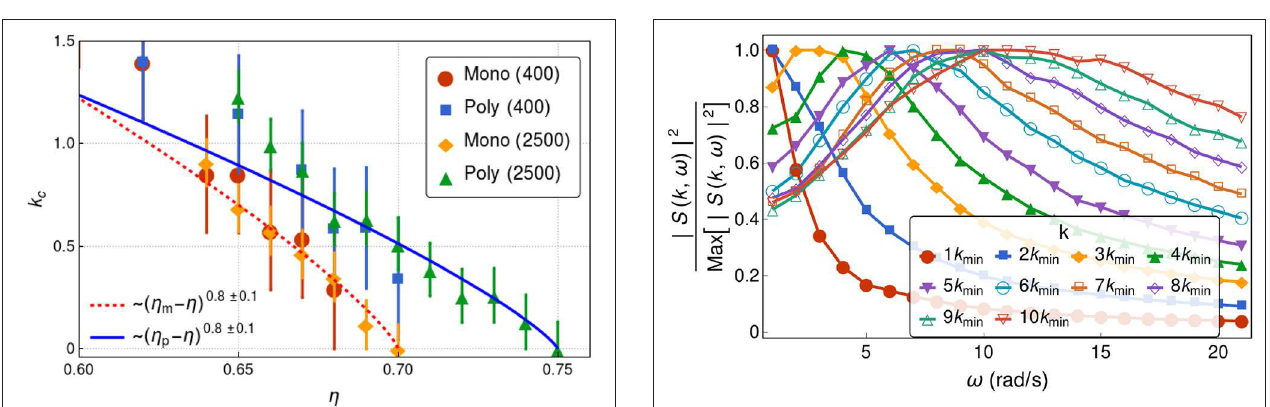
FIGURE 5 | The transverse density current correlation function as a function of FIGURE 3 | Dynamical gap vs. reduced packing fraction η/η c where η c es the ω for different wavenumbers. This was obtained for polydisperse hard-disks at k min . The data points correspond to the packing fraction such that k c a packing fraction 0.73. Notice that for all curves where k < 3 k min , the = simulations while the dashed lines corresponds to fits (see legends). For maximum is located at ω 0. For k 3 k min , the peak moves to higher = ≥ monodisperse disks η c 0.7 while for polydisperse disks η c 0.75. The frequencies as k increases, indicating transversal wave propagation although = = computations were made for systems with N 400 and N 2,500 disks as with an increased damping. = = indicated in the labels.